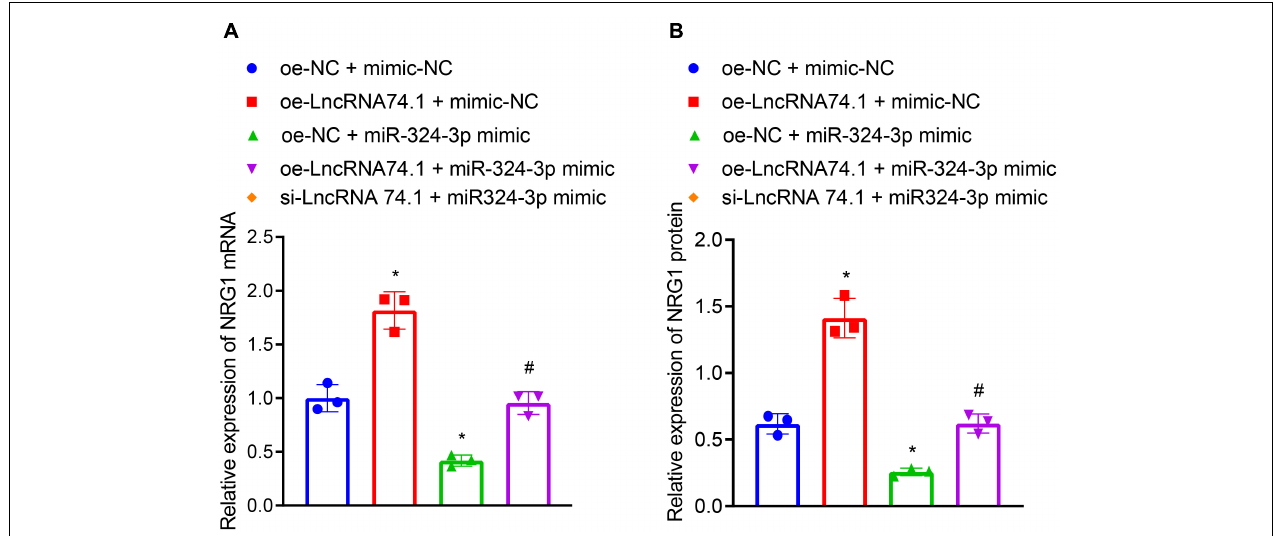
FIGURE 4 | LncRNA 74.1 binds to miR-324-3p to promote NRG1 expression. (A) RT-qPCR results of NRG1 mRNA expression in HK-2 cells with different treatments; (B) Western blot results of NRG1 protein expression in HK-2 cells with different treatments; * p < 0.05 as compared with oe-NC + mimic-NC; # p < 0.05 as compared with oe-lncRNA 74.1 + mimic-NC. The measurement data were expressed as mean ± standard deviation. One-way ANOVA was used for data comparisons among multiple groups, followed by Tukey’s post hoc test. The cell experiments were repeated three times